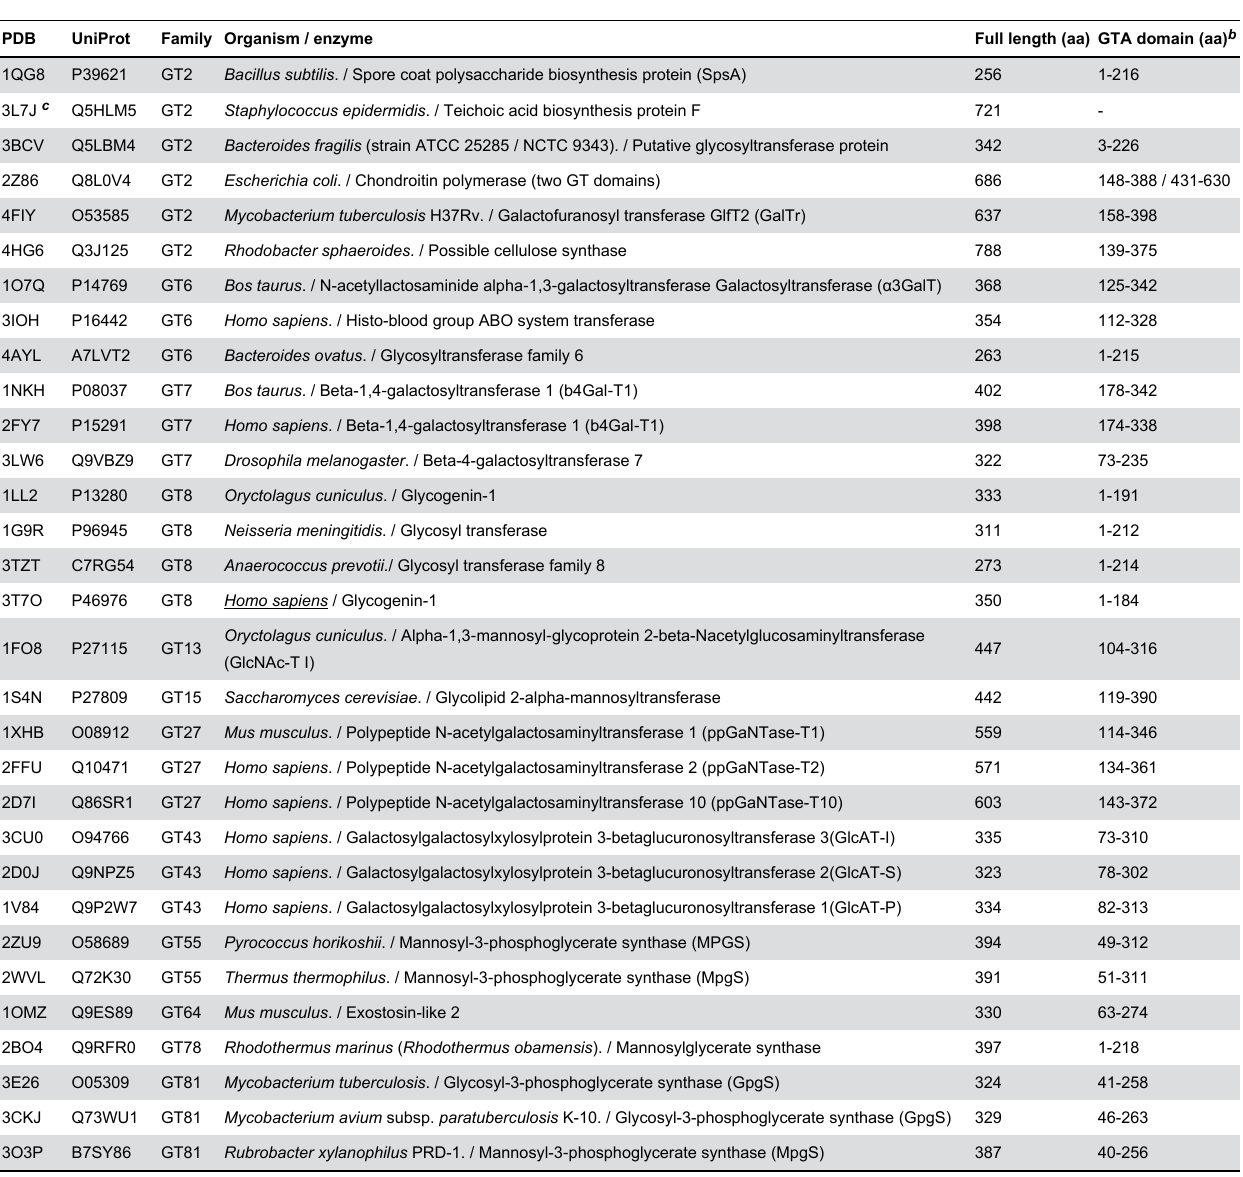
a . For those enzymes with more than one PDB file, the structure with highest resolution was taken. b . Amino acid residues corresponding to the GT domain and used in the sequence alignments c . The PDB file corresponds to the glycerophosphotransferase domain of Q5HLM5, whereas the glycosyltransferase domain is not solved.